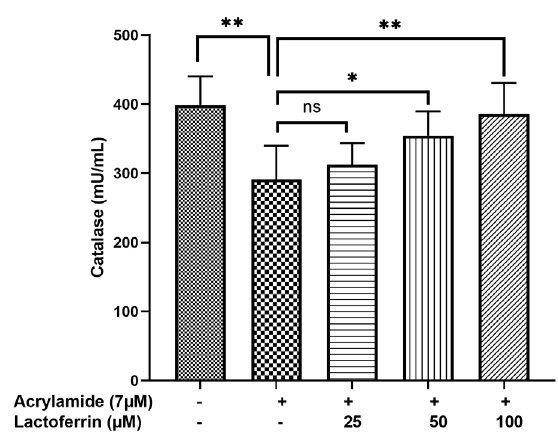
Figure 3. Protective effect of lactoferrin on catalase against acrylamide-induced oxidative stress in HepG2 cells. The results were shown with mean±standard deviation. ns: not significant * p < 0.05, ** p <